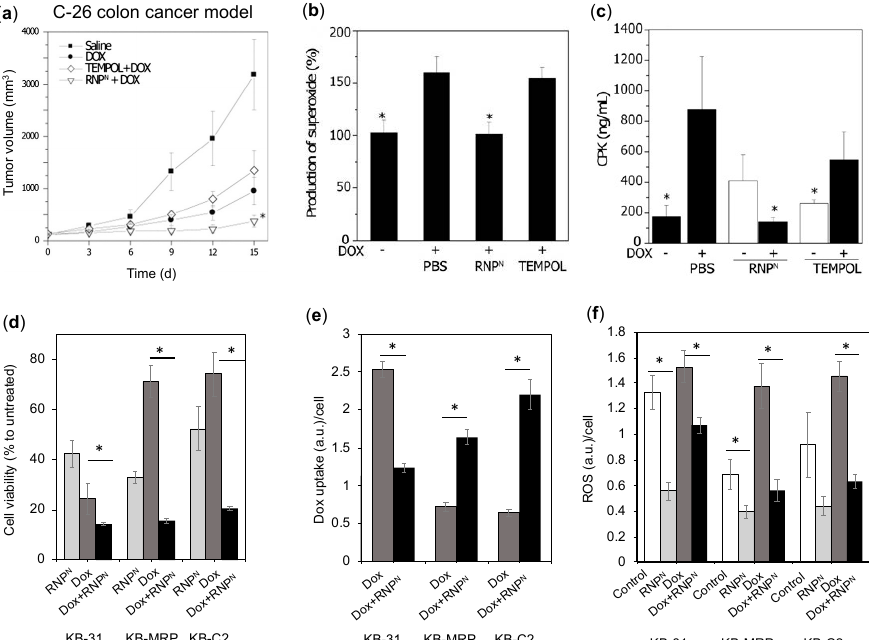
Figure 9. (top) . RNP increases the therapeutic effect of doxorubicin (Dox) in a colon cancer model. ( a ) Tumor growth profile of subcutaneous colon tumor (C-26) pre-treated with RNP N (i.v., 100 mg/day for 4 days, days − 4 to − 1), followed by a single injection of DOX (i.v., 10 mg/kg on day 0). The ability of RNP N to inhibit the cardiotoxicity of Dox mediated by increased ROS [82]; ( b ) inhibition of superoxide level by RNP N in the heart homogenates, ( c ) creatine phosphokinase (CPK) in plasma, a marker of heart damage. Mice were intravenously injected with RNP N (25 mg/kg/day) and LMW-TEMPOL (4 mg/kg/day), followed by DOX (20 mg/kg, i.v.) 30 min later. 3 days post Dox administration, samples were analyzed. ( bottom ). RNPs increases the therapeutic effect of Dox by overcoming drug resistance in the epidermoid cancer cell lines. ( d ) Cytotoxicity of combination treatments: RNP N (2 mg/mL) and Dox (5 µ g/mL) for 48 h in epidermoid cancer cell lines-drug sensitive KB-31, drug-resistant KB-MRP overexpressing drug efflux transporter, MRP-1 and drug-resistant KB-C2 overexpressing drug efflux transporter, P-gp; ( e ) Dox uptake in epidermoid cancer cell lines after 2 h of treatment (RNP N (2 mg/mL) and Dox (5 µ g/mL)). ( f ) ROS level after 24 h of treatment with RNP N (2 mg/mL) and Dox (5 µ g/mL) in epidermoid cancer cell lines [130]. * p < 0.05 was considered significant. This figure is reproduced with permission from Reference [82] and adapted from [130]. Copyright 2013, Elsevier B.V.; Copyright 2017, Elsevier